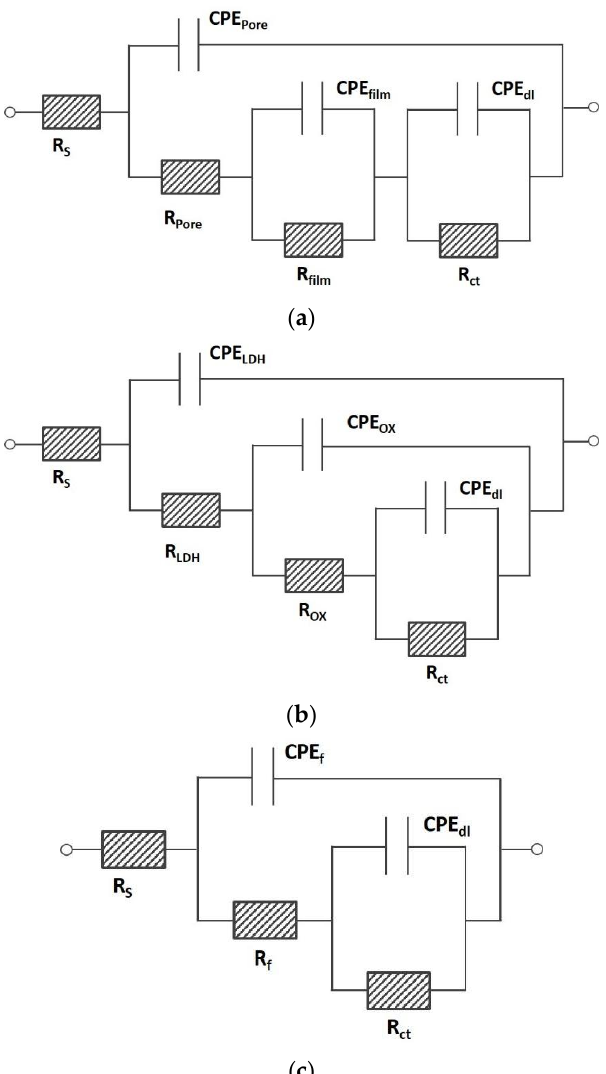
Figure 5. Schematic of the circuits employed to fit the experimental data set of LDH coatings developed on aluminum alloys: ( a , b ) three-time constants and ( c ) two-time constants.